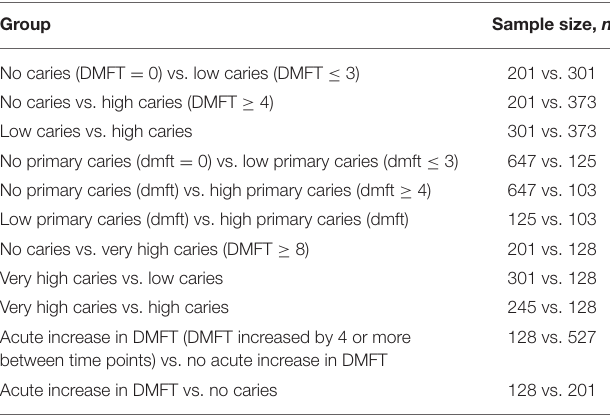
TABLE 1 | Groups created in the previous study based on dmft/DMFT